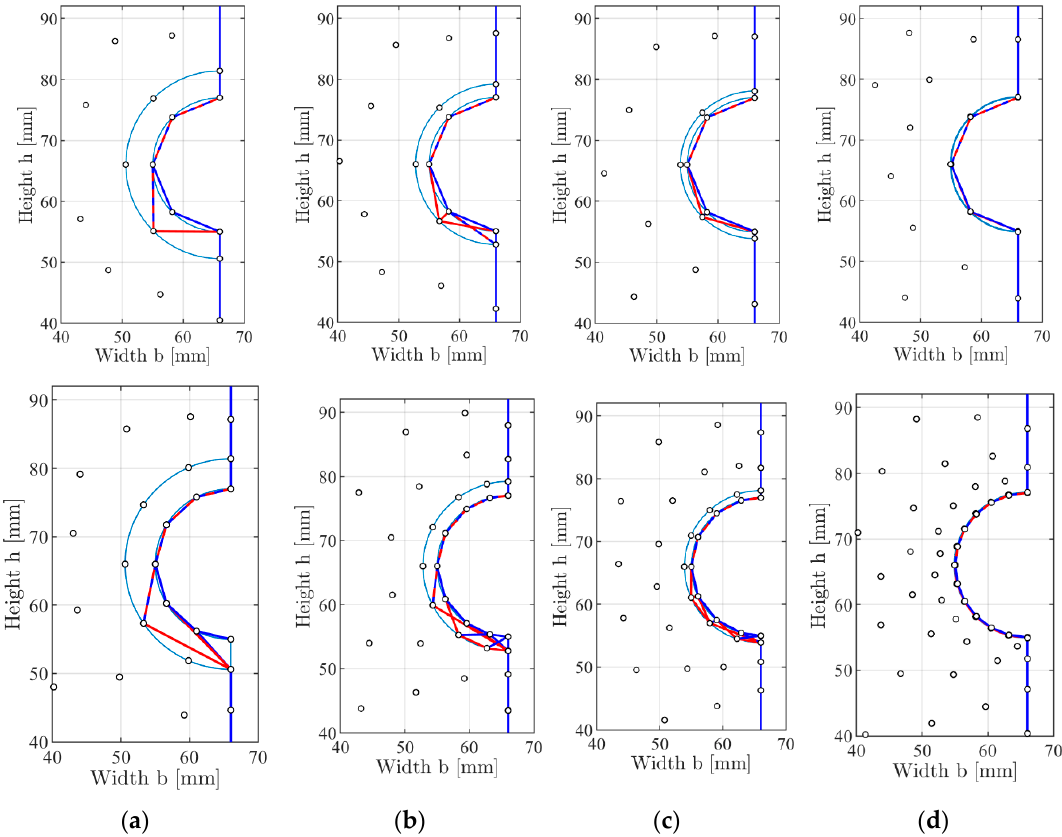
Figure 15. Collapse mechanisms (blue: Slip displacements, red: Normal displacements) from DLO at the compression-only support for di ff erent node distributions (top row: Coarse mesh; bottom row: Fine mesh), the M ises criterion and di ff erent k d0 values: ( a ) k d0 = 1.40; ( b ) k d0 = 1.20; ( c ) k d0 = 1.10; ( d ) k d0 = 1.01. Table 2. Ultimate loads in kN for di ff erent k d0 values and di ff erent node distributions (first value: T resca criterion; second value: M ises criterion; third value: Total number of nodes around the